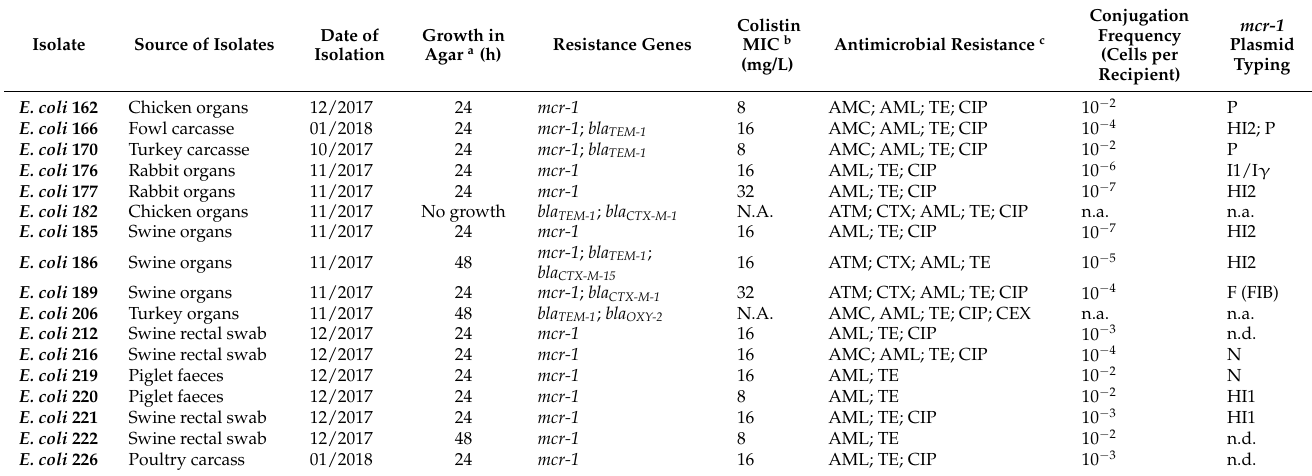
Table 3. Origin, phenotypic and genetic characteristics of antimicrobial resistance of mcr-1 positive and/or ESBL-producing E. coli isolates.